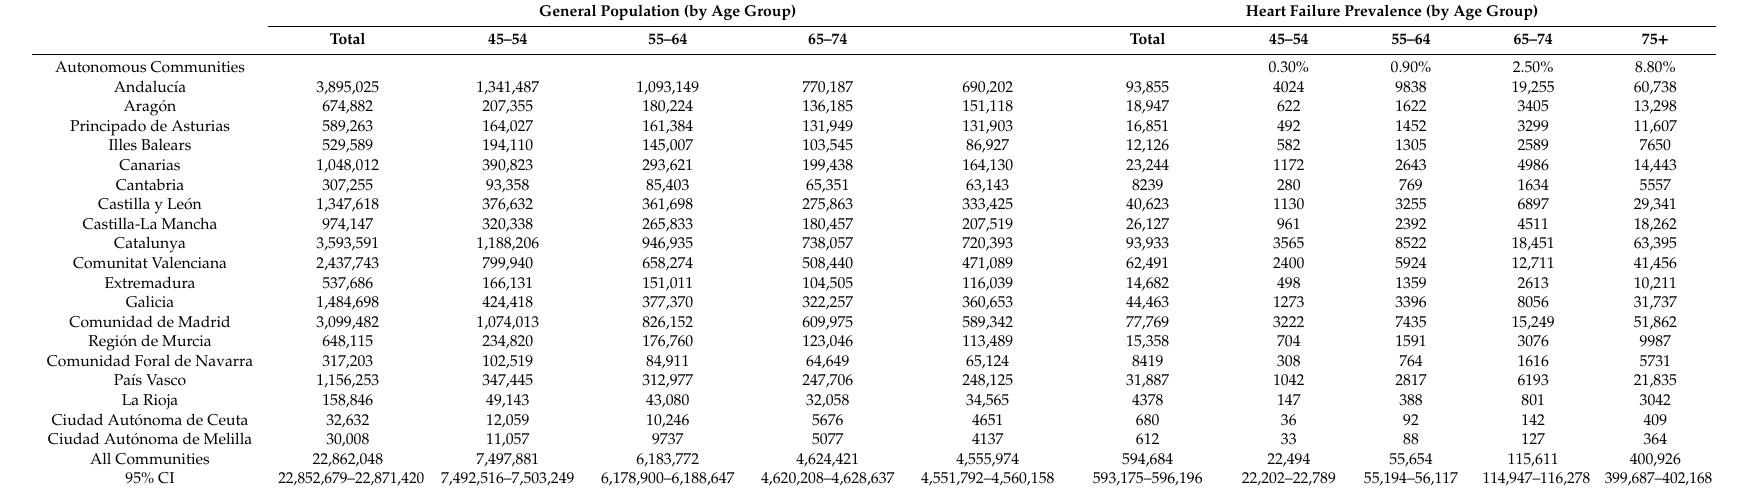
Table 4. Total population in Spain according to 2019 data from the National Statistics Institute [26], and the number of patients with heart failure in Spain and its autonomous communities, according to prevalence data published by Farr é et al.